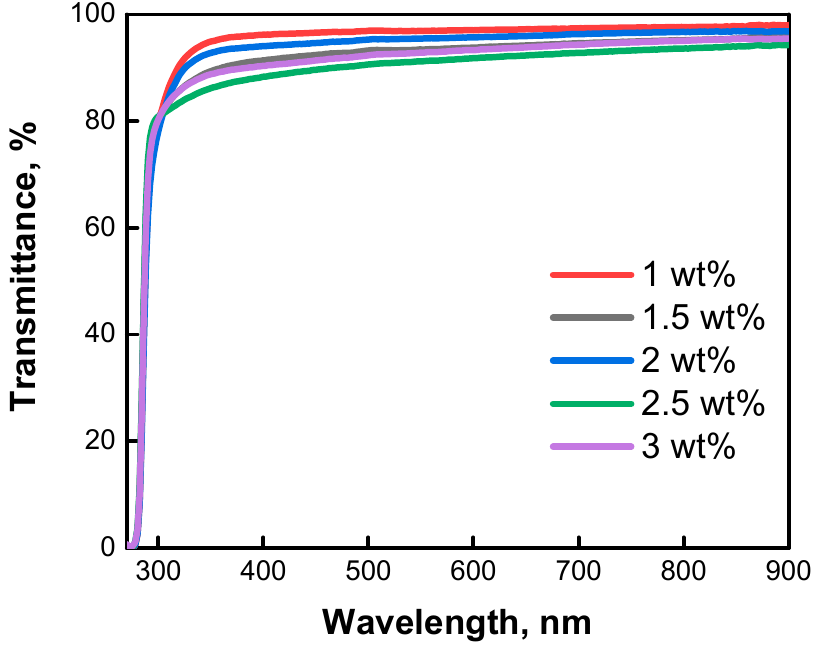
Figure 5. UV-Vis transmittance spectra of ETLs on glass substrates prepared using ETL inks with different SnO 2 QD concentrations.